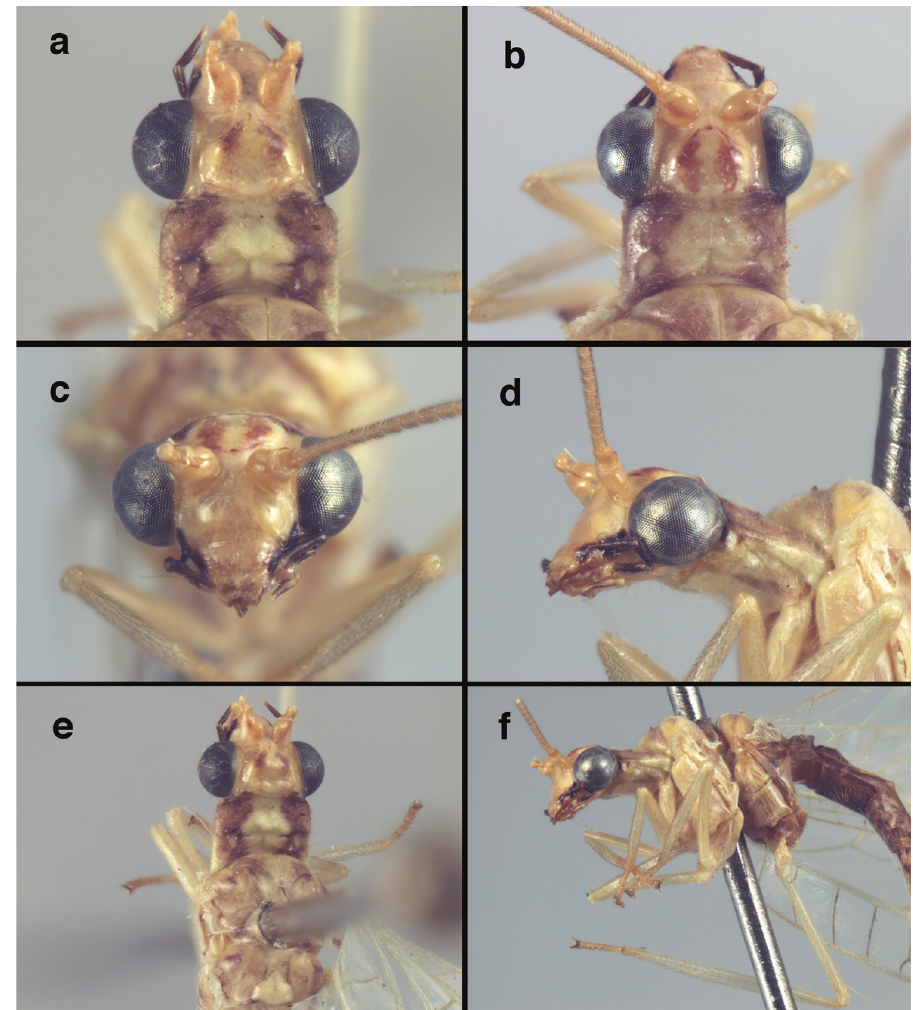
Figure 26. Ungla demarmelsi Sosa: External features, ( a, b ) head, prothorax, dorsal ( c ) head, frontal ( d ) head, prothorax, lateral ( e ) head, thorax, dorsal ( f ) body, lateral (all: Venezuela, Distrito Capital, USNM; a, c–f male; b female). with basal two segments pale, distal three segments dark brown to black; labial palp with basal two segments pale, distal one with dark brown. Thorax mostly green (living specimens) to cream-colored (preserved specimens). Prothorax short, flat, with broad, red to reddish brown, lateral stripes; transverse fur- row shallow in middle region, with yellowish spots at lateral margins; setae on dorsal, lateral surfaces long, slender, yellow to reddish, dense laterally. Mesothorax, metatho- rax with reddish to reddish brown laterally. Legs pale cream-colored, without marks. Measurements: head width: 1.3–1.4 mm; ratio head width : eye width: 2.2 : 1; protho- rax width: 1.0–1.1 mm, length: 0.4–0.5